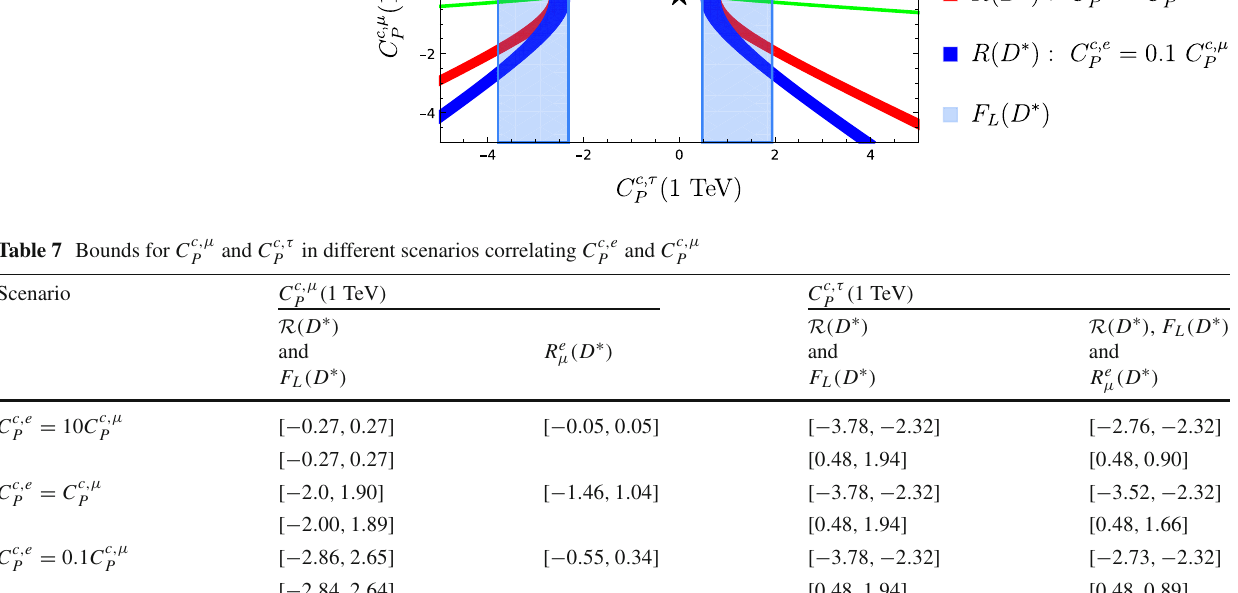
Table 7 Bounds for C c